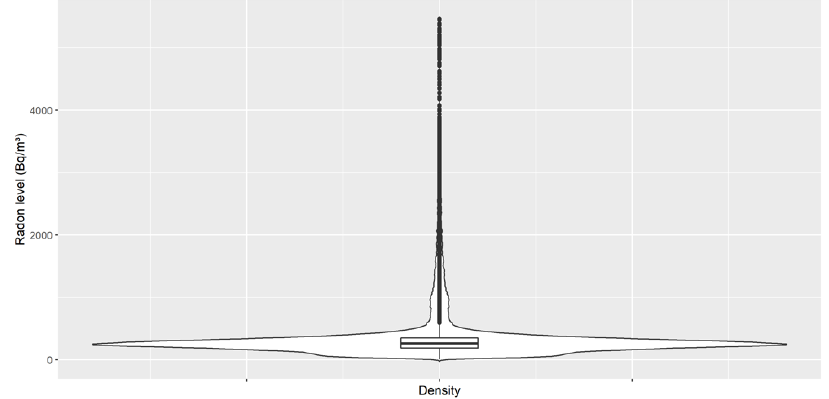
Figure 3. Radon violin plot for outlier detection.